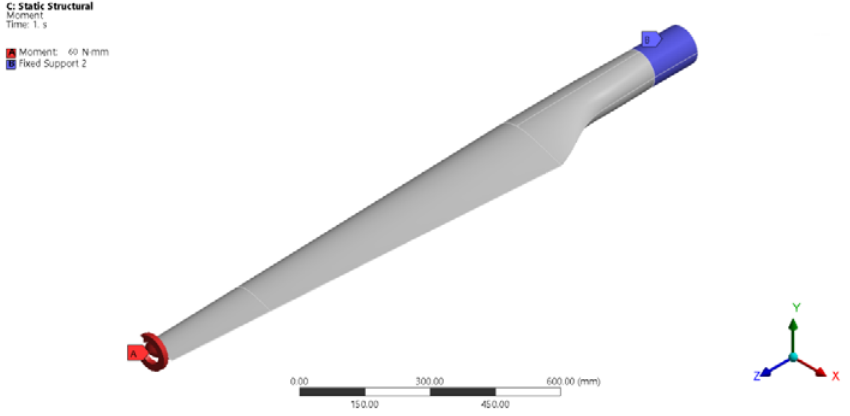
Figure 6. Support and loading scheme.